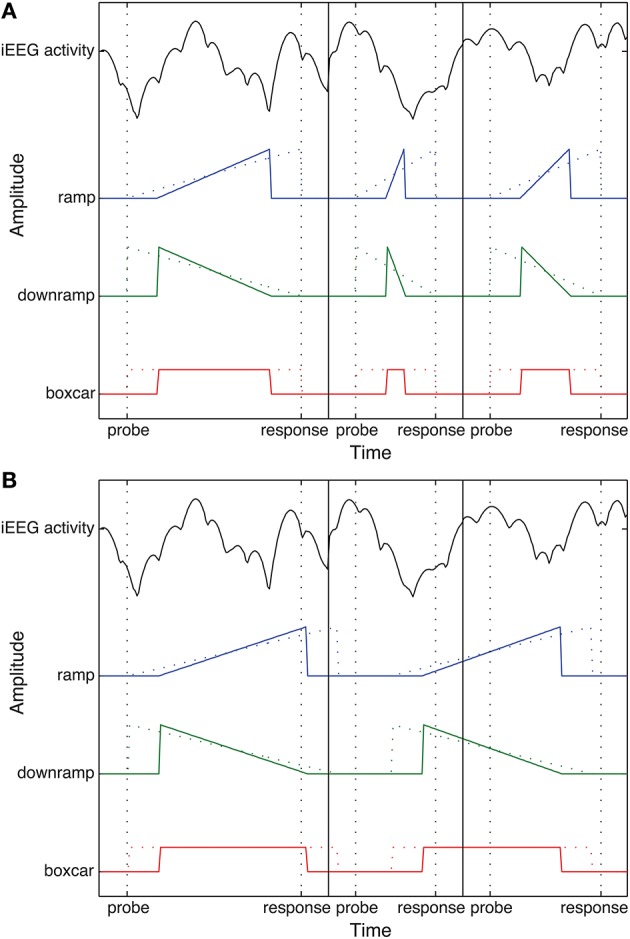
(A) Example time courses of one electrode's theta activity and the matching ramp, downramp, and boxcar regressors for three consecutive trials. (B) Example time courses of “random” ramp, downramp and boxcar regressors: made using randomly shuffled reaction times. Note that in this case, onset and offset of the ramp no longer correspond to “probe” and “response,” respectively. Dotted colored lines show time course of regressors before correction for non-decision time. Vertical lines indicate borders between real task trials.